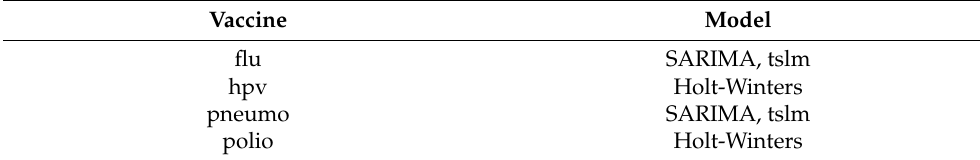
Table 3. List of training model according to the best